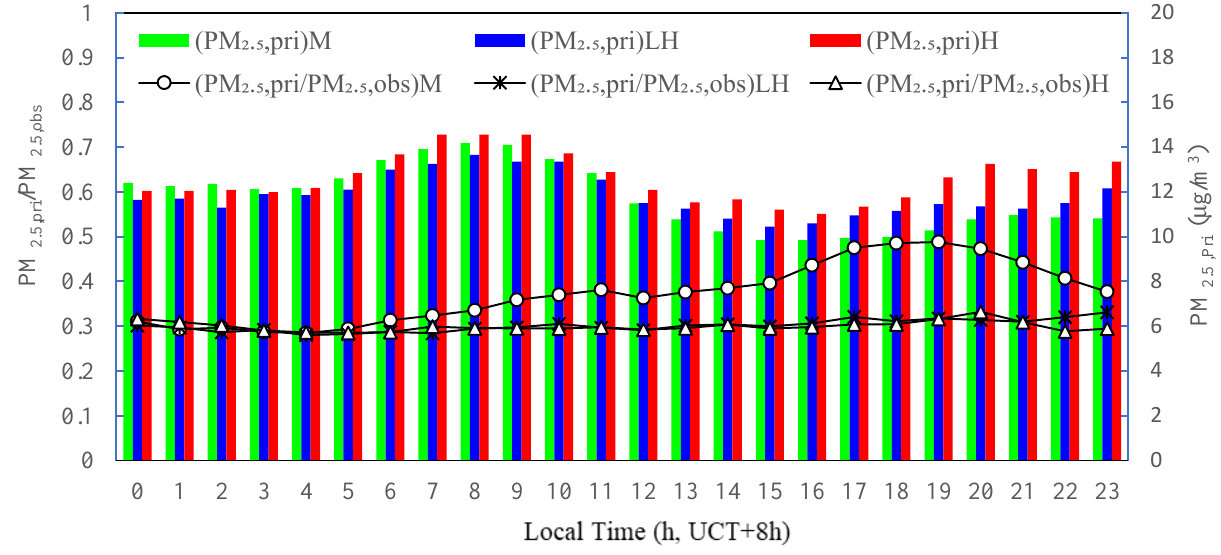
Figure 6. Diurnal variations in estimated primary PM 2.5 mass concentrations and ratio of primary to observed PM 2.5 mass concentrations at different photochemical activity levels in the summertime 2020 in Tianjin, China.